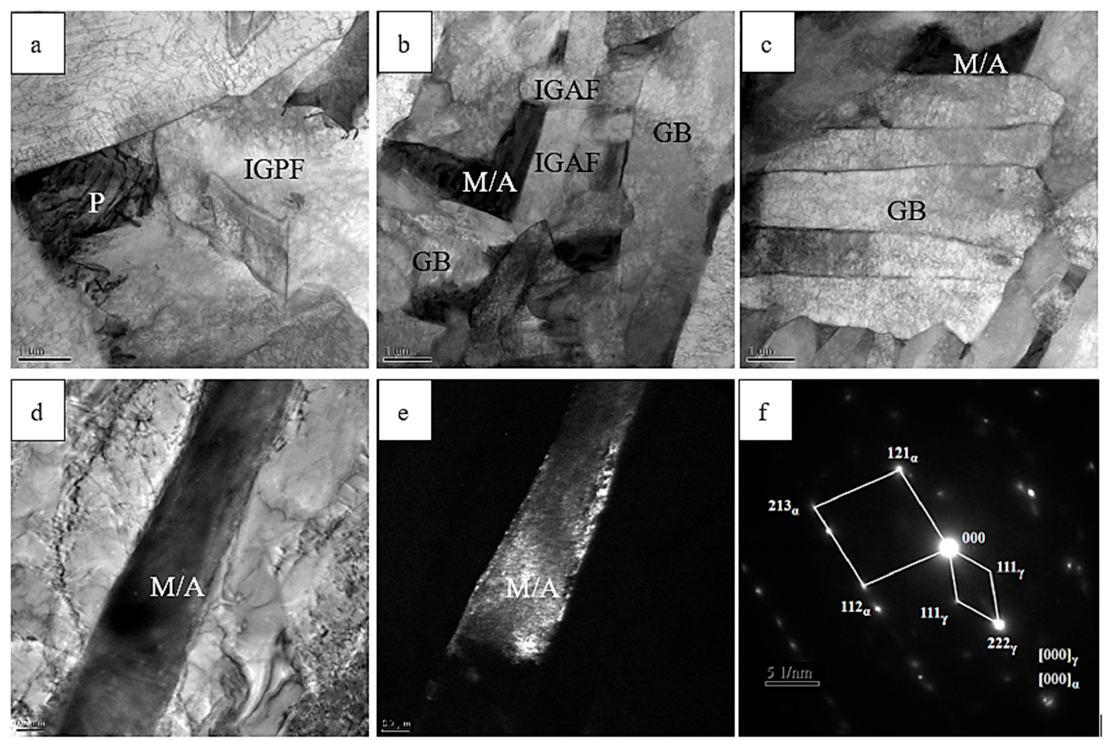
Figure 6. TEM micrographs of the microstructure of the simulated samples of ( a ) 120 kJ/cm, ( b ) 65 kJ/cm, and ( c ) 35 kJ/cm, and the M/A manifested by ( d ) bright field and ( e ) dark field, and ( f ) diffraction pattern of the selected area.